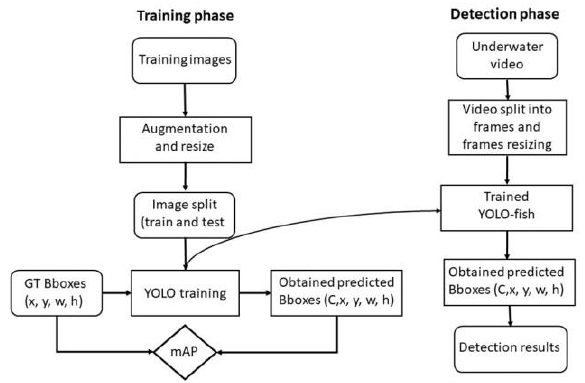
Figure 5 . A flowchart of training and detection process of YOLO-Fish model.